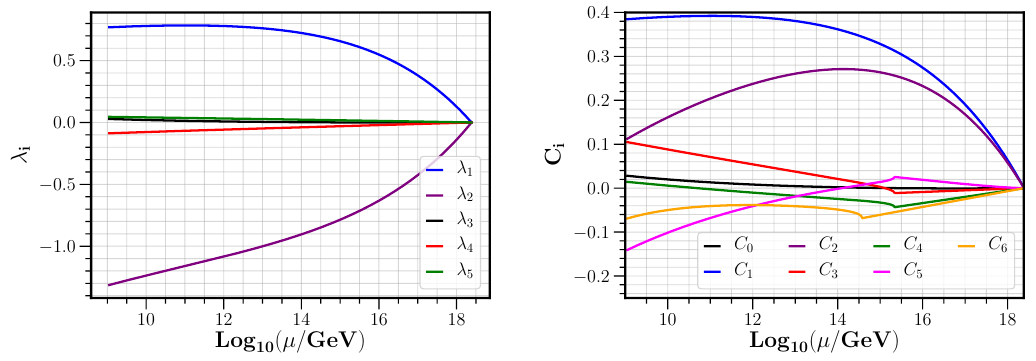
Figure 5 . Running of the quartic couplings (left figure) and the conditions for the classical stability of the potential (right figure) for M ∆ = 10 9 GeV and Y ∆ ( M pl ) = 1 , without right-handed neutrinos. Left: all quartic couplings vanish at the Planck scale. The running of λ 1 and λ 2 has opposite trends, and similar for λ 4 and λ 5 . This is due to the different sign of the contribution of the gauge and neutrino Yukawa couplings in eq. (3.8)–(3.11). Right: we display the values of the constraints C i discussed in section 3.3, with a stable potential for positive C i . The interaction of the triplet with left-handed leptons, Y ∆ , stabilises the potential of the triplet alone, that is C 1 , C 2 > 0 , even though λ 2 < 0 . The other conditions are in general not met. In particular, we have that C 5 , C 6 < 0 evaluated at M ∆ . Also we find that λ 3 < 0 for µ & 10 15 GeV (see figure 3). This is the reason why the lines corresponding to C i with i = 3 , 4 , 5 , 6 change at µ & 10 15 GeV . For these contributions we employ the real part of the square root of λ 3 in eqs. (3.19) and (3.20).